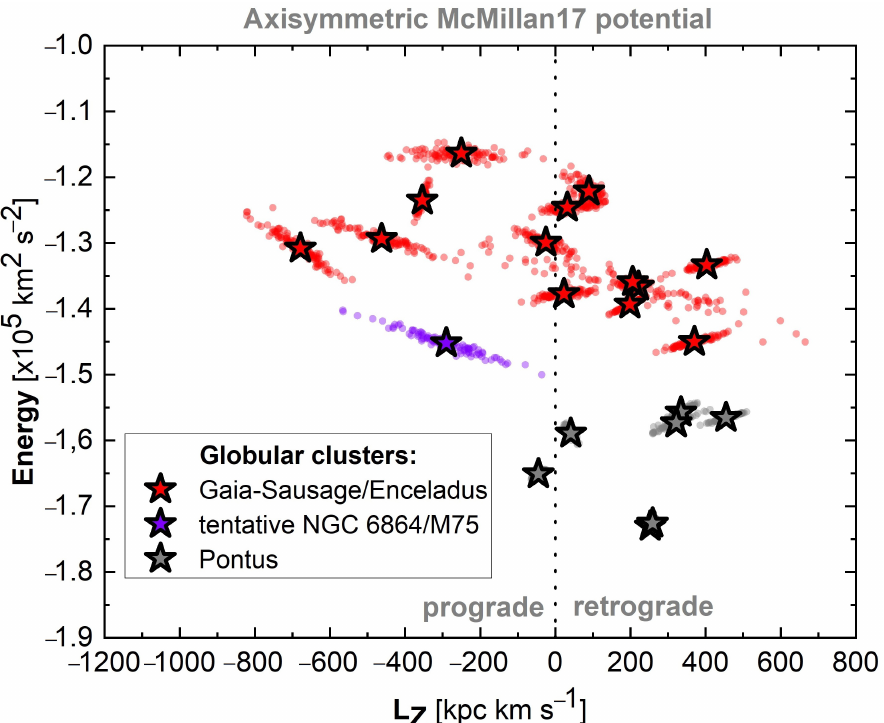
Figure 1. Positions of the globular clusters in the ( L z , E ) -plane. Asterisks mark the mean values of L z and E . Red—GSE; grey—Pontus globular clusters; purple- the tentative NGC 6864/M 75 cluster. The dots show one hundred randomly chosen globular cluster locations consistent with the errors in Table 1. We have assumed a normal distribution with the standard deviations set by the